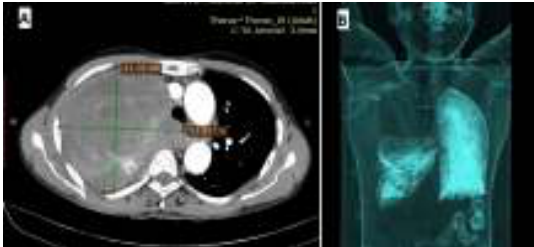
Figure 1 : Computed tomography (CT) revealed (A) a sizable well delineated retrosternal soft tissue mass (13.78x13.85 cm) that occupied the majority of the right hemithorax and (B) compressed the right upper bronchus with atelectatis lung. This mass showed inhomogeneous enhancement after contrast administration.